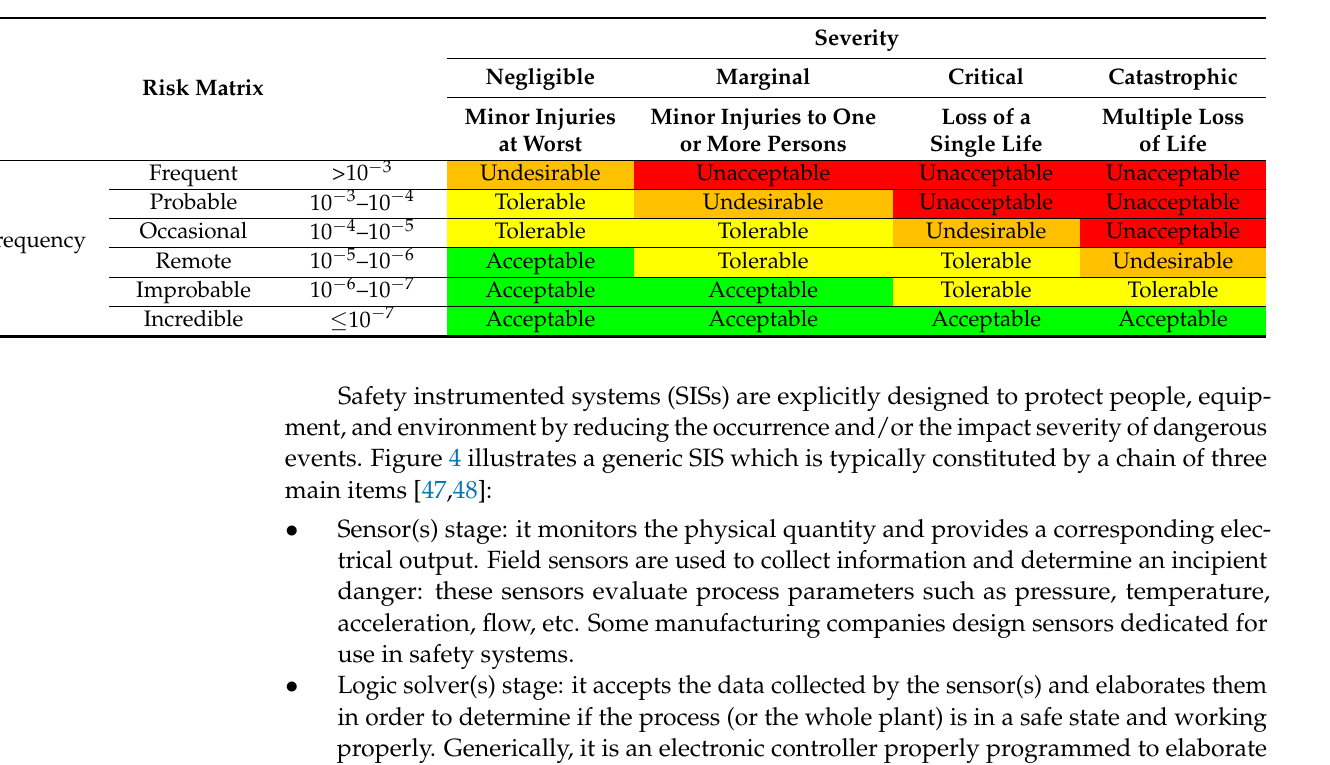
Table 1. Risk matrix in compliance with IEC 61508:2010